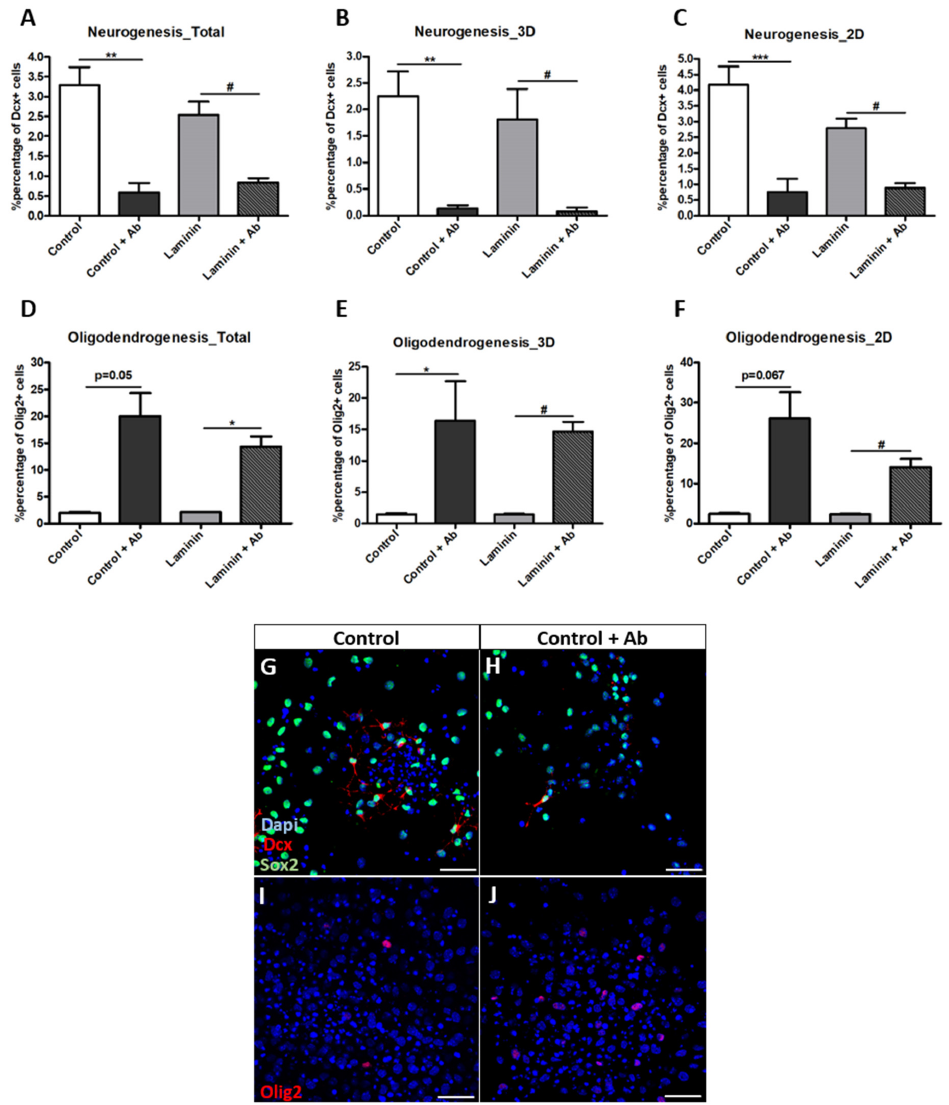
Figure 4. The blocking of integrin- β 1 further enhances the divergence between neurogenesis and oligodendrogenesis in polymorphic assays in vitro. ( A – C ) Graphs showing the total percentage of Dcx+ cells in the cultures ( A ) and within separate microenvironments ( B , C ) (** p < 0.01, *** p < 0.001 comparison between “control” and “control + Ab” groups; # p < 0.05 comparison between “Laminin” and “Laminin + Ab” groups). Statistical analysis was performed by one-way ANOVA, followed by LSD post hoc tests; n = 3 for total/2D microenvironments and n = 2–3 for 3D microenvironments. ( D – F ) Graphs showing the total percentage of Olig2+ cells in the cultures ( D ) and within separate microenvironments ( E ,F) (* p < 0.05 comparison between “control” and “control + Ab” groups; # p < 0.05 comparison between “Laminin” and “Laminin + Ab” groups). A statistical analysis was performed by: (1) a repeated measures ANOVA for total and 2D microenvironments ( n = 3 samples per group) and (2) one-way ANOVA followed by LSD post hoc test for 3D microenvironments ( n = 2–3). ( G – J ) Representative images of NSCs differentiated for 7d with or without the addition of the integrin- β 1 blocking antibody to the differentiation medium and after immunostaining for Dcx ( G , H ) or Olig2 ( I , J ). [Error bars: SEM; scale bars, 40 µ